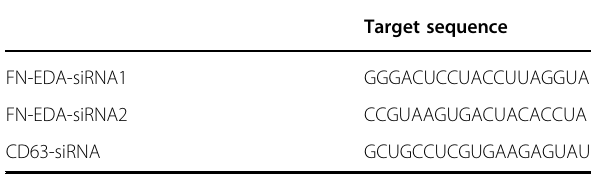
Table 2 Target sequences for